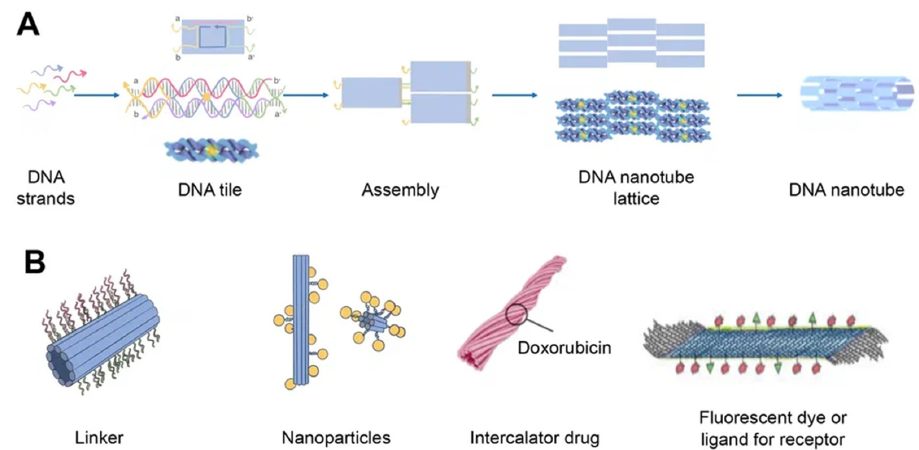
Figure 4. Schematics of DNA nanotube folding, modifications, and drug loading. ( A ) DNA nanotube self-assembly (schematically) using the single-stranded tile method. Five DNA strands form DNA double-crossover tiles. A DNA tile is formed with four short single-stranded sections called sticky ends (marked a, b, a ′ , and b ′ ) that act as binding domains. Individual helical domains are connected by interhelix crossovers. Each domain is complementary to one domain of neighboring tiles and several domains hybridized with each other to form nanotubes (the single-stranded tile method of assembly of DNA nanotube). This interaction is provided due to complementary interactions of their sticky ends. Tiles can be schematically represented as molecular bricks with complementary connectors. The sticky end arrangement directs the hybridization of DNA tiles to form tubular DNA structures with a range of diameters. Their distribution is determined by the thermodynamics and kinetics of the DNA nanotube assembly process. ( B ) Modifications of DNA nanotubes: linker (CpG, cholesterol, aptamers, etc.); nanoparticles (Au); chemotherapy or photodynamic therapy drug; other